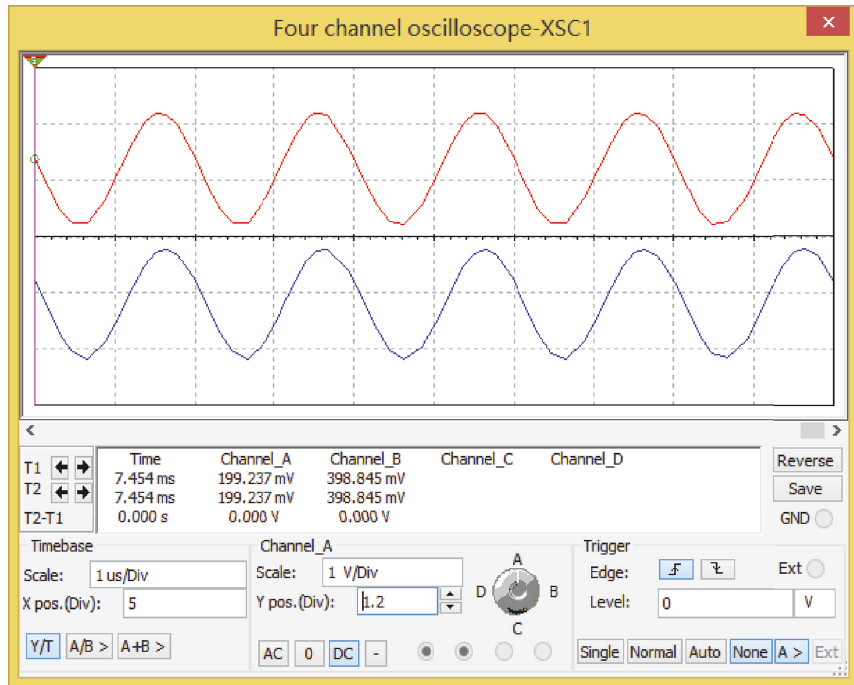
Figure 23: 500 KHZ.